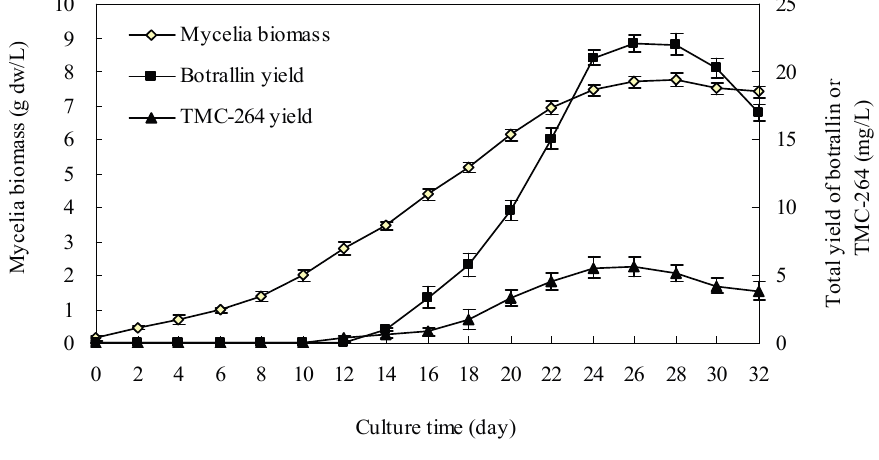
Figure 1. Time courses of mycelial growth, and production of botrallin and TMC-264 in liquid culture of Hyalodendriella sp. Ponipodef12 (error bars for standard deviations, n =